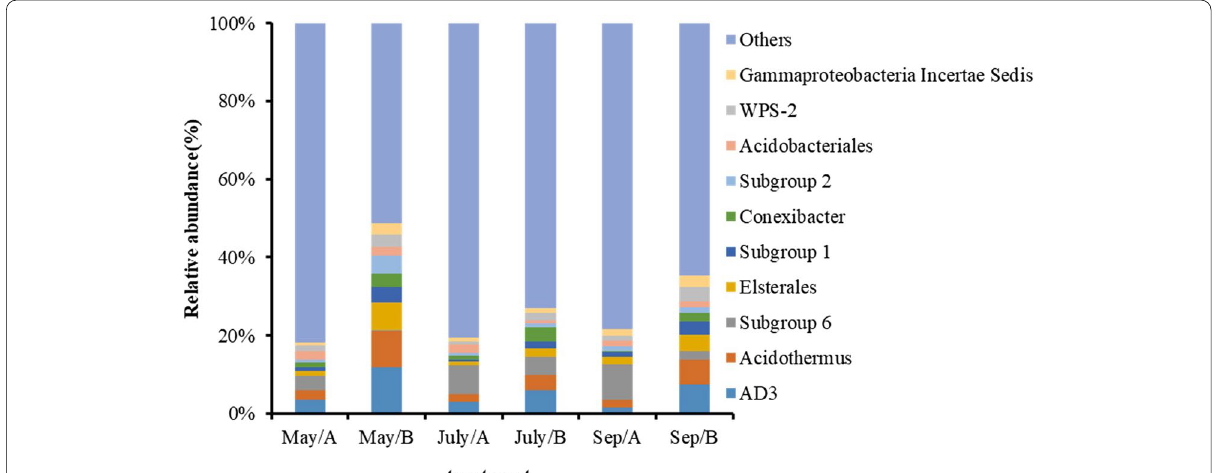
Fig. 3 Relative abundance of main bacterial populations in soil in banana intercropping and monoculture. May/A in May. May/B Monoculture treatment in May. July/A = Intercropping treatment in September. Sep/B